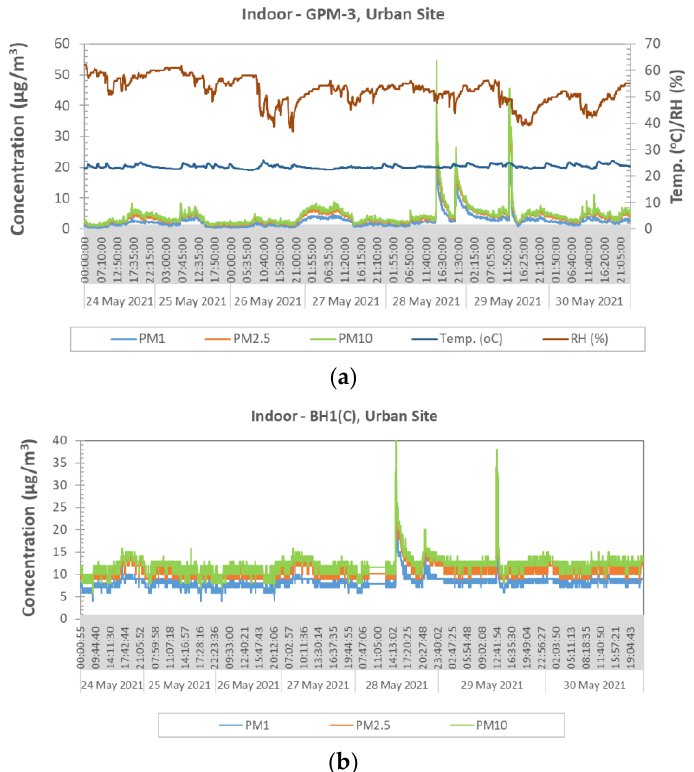
Figure 13. Temporal PM and microclimatic data series for GPM ( a ) and BH1 ( b ) monitors at the urban site, performed indoors (anteroom) between 24 and 30 May 2021 (sampling rate: 1–5 min, n = 2300).